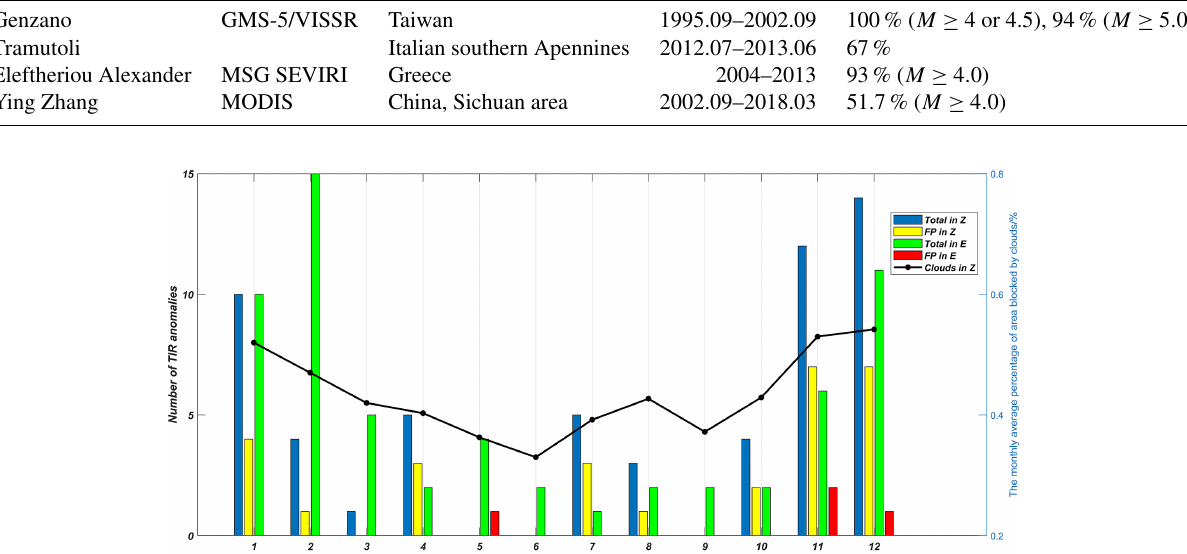
Table 4. A general summary of research on the statistical correlation between TIR anomalies and earthquakes. Author